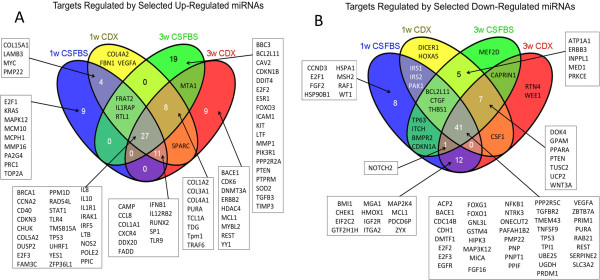
Analysis of treatment specific targets regulated by validated miRNAs. A) Venn diagram showing specific targets that are potentially regulated by miRNAs that are up regulated in different treatment conditions. Putative targets were identified based on the regulatory network generated by IPA software. B) Venn diagram depicting predicted targets regulated by the down-regulated miRNAs in different treatment conditions. Targets were identified based on the regulatory network using IPA software.